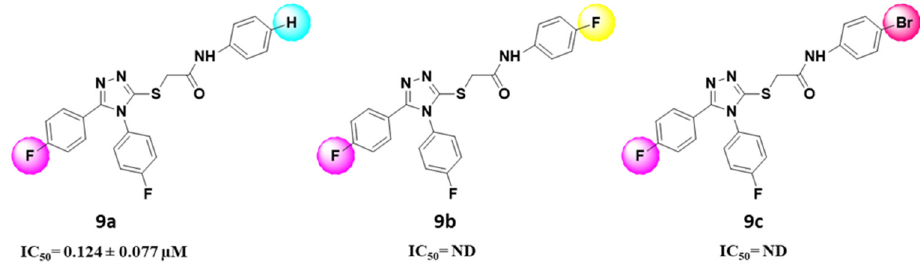
Figure 1. Structural activity relationship of 9a , 9b, and 9c .